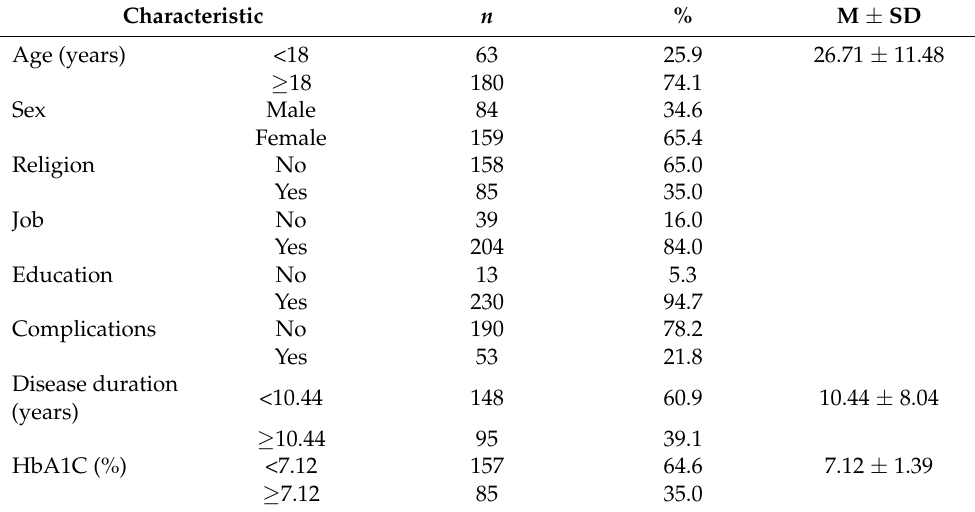
Table 1. Participants’ characteristics ( n =